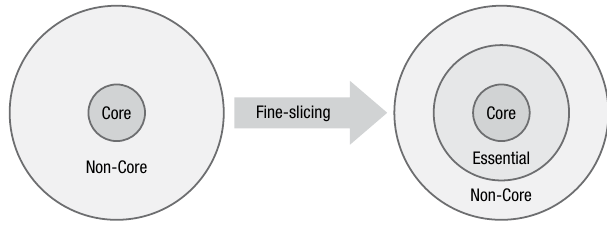
Fig. 3. Core and non-core activities Source: Adapted from Quinn (1999).